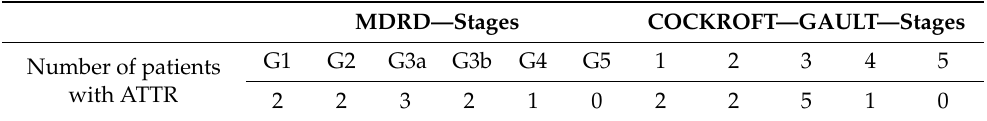
Table 8. MDRD and Cockcroft–Gault staging for ATTR positive patients.